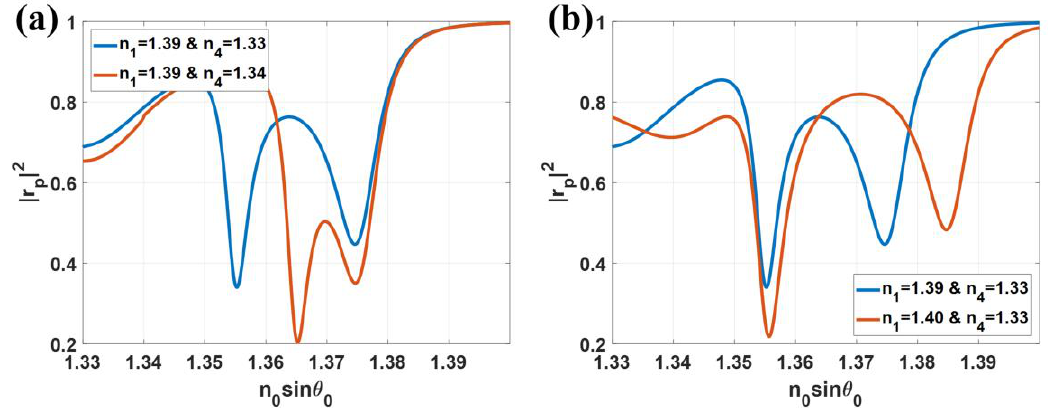
Figure 13. ( a ) |r p | 2 responses when n 1 = 1.39, n 4 = 1.33 (blue curve) and 1.34 (red curve) and ( b ) |r p | 2 responses when n 1 = 1.39 (blue curve) and 1.40 (red curve) and n 4 = 1.33.